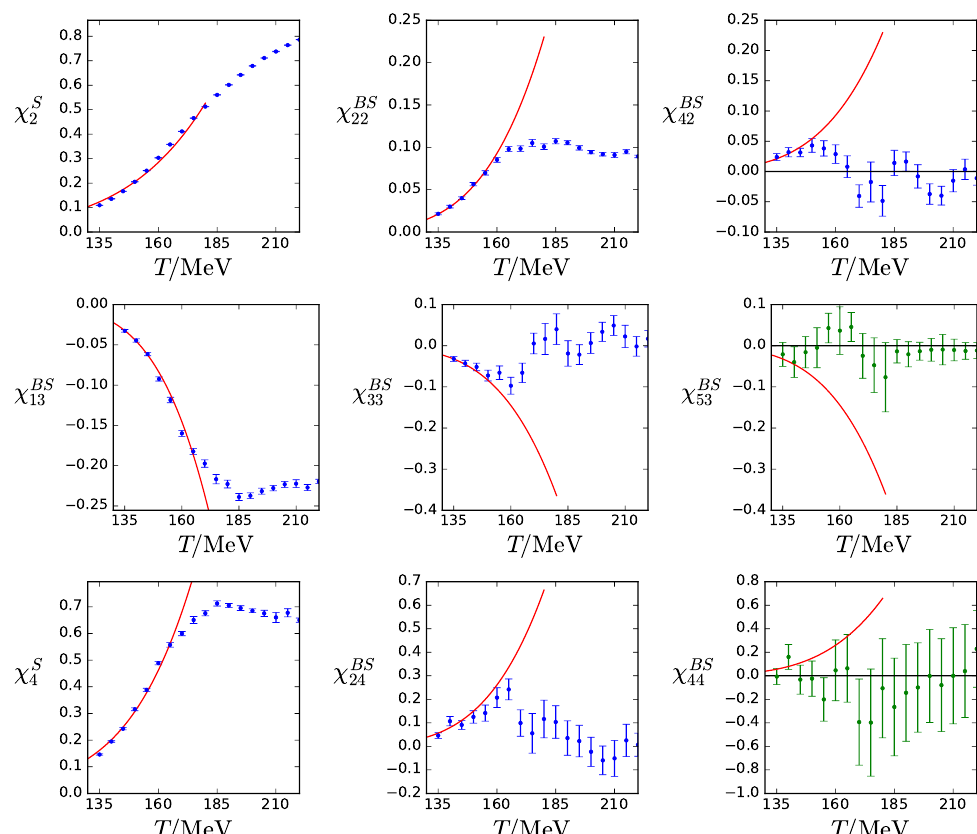
Figure 10 . Results containing no electric charge derivative on the various correlators on our 48 3 (cid:2) 12 lattice as functions of the temperature. Green data points denote our estimates for the high orders, these were (cid:12)tted using a prior distribution. The red curves are the HRG model